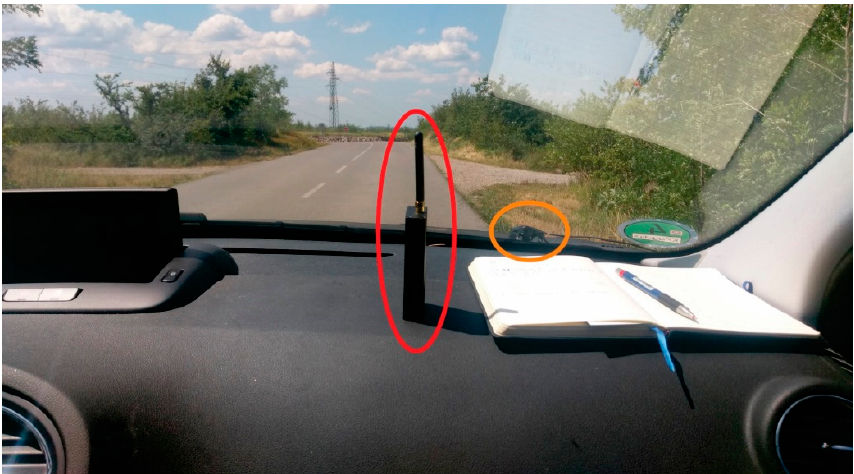
Figure 3. Position of the battery jammer (red ellipse) on the front panel and the GNSS receiver’s (Ublox, NEO 6T) patch antenna on outer windscreen surface (orange ellipse) (own study).